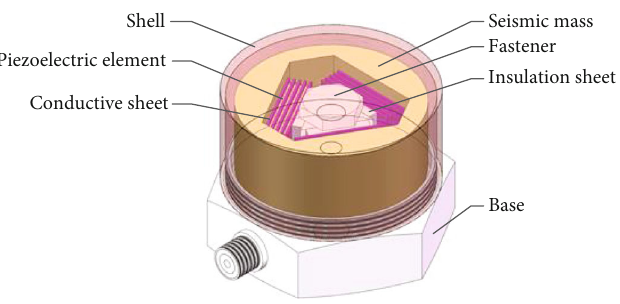
Figure 1: Structure of the triangular shear piezoelectric acceleration sensor.